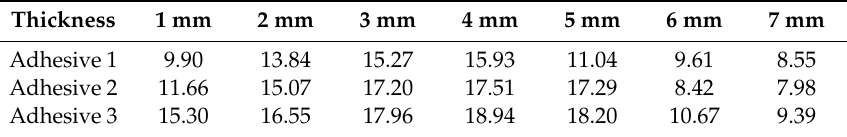
Table 2. Maximum Shear Stresses (Unit: MPa).